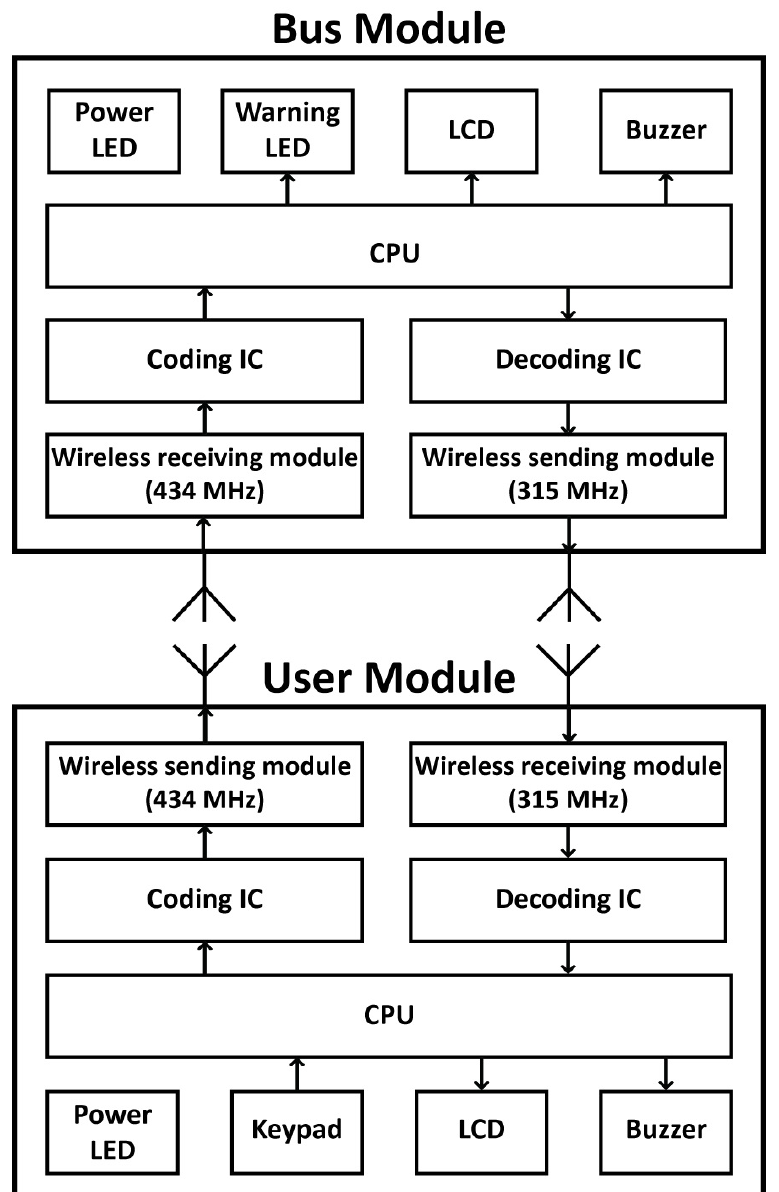
Figure 1. System framework of the user module and the bus